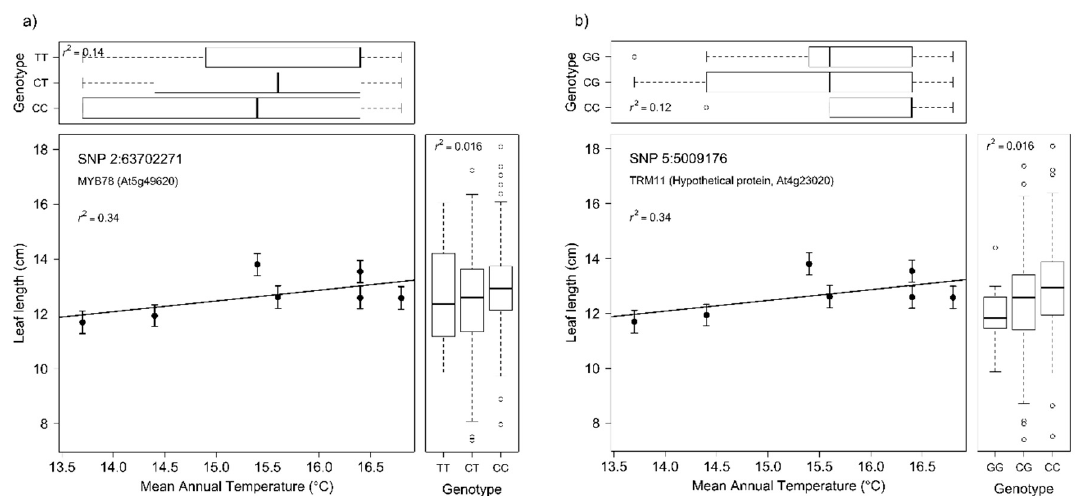
Figure 3. Examples of corroboration between three independent association analyses in Eucalyptus microcarpa (Grey box)–genotype (SNP; ( a ) SNP 2:63702271, ( b ) SNP 5:5009176), phenotype (leaf length) and climate (mean annual temperature). Main plot = trait (provenance level best linear unbiased estimates, BLUEs) vs. climate. Box plot (right) = SNP vs. trait (provenance BLUEs). Box plot (top) = SNP vs. climate. Error bars in main plot = 95% confidence interval. Box plot whiskers extend to 1.5 × interquartile range.